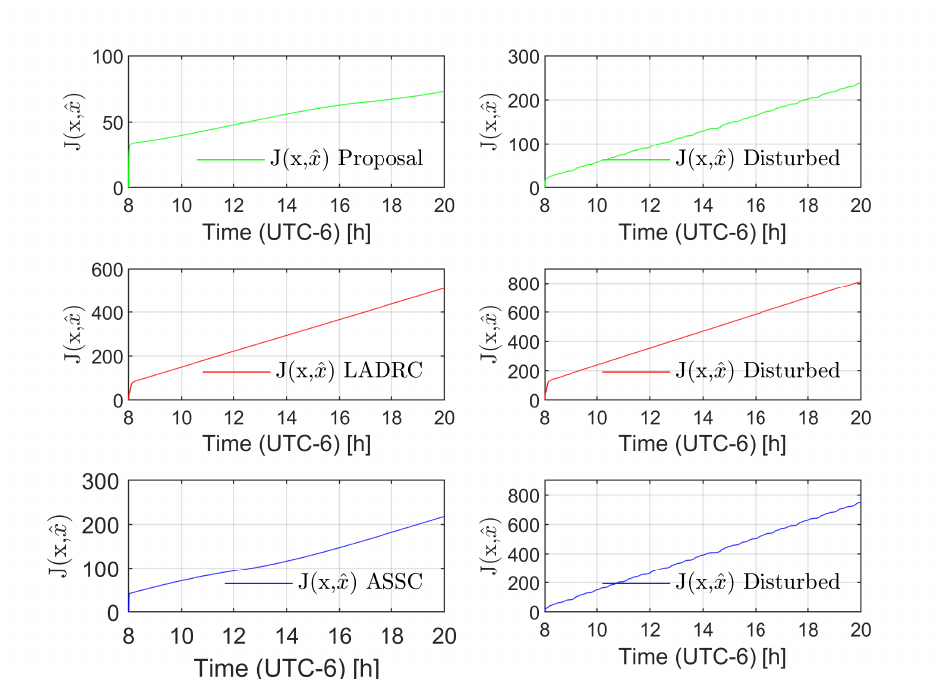
Figure 9. Performance index behavior of the state estimation. The graphics on the left side denote the case without disturbance and the graphics on the right side show the performance in presence of